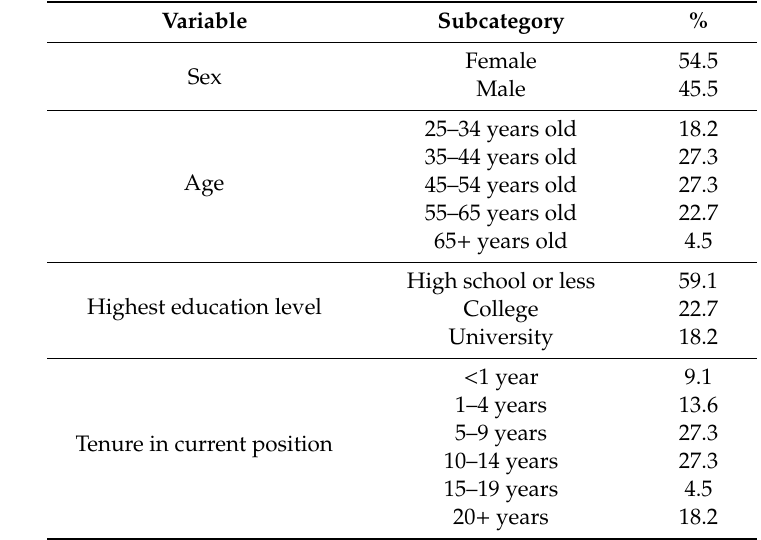
Table 1. Characteristics of respondents (N = 22).